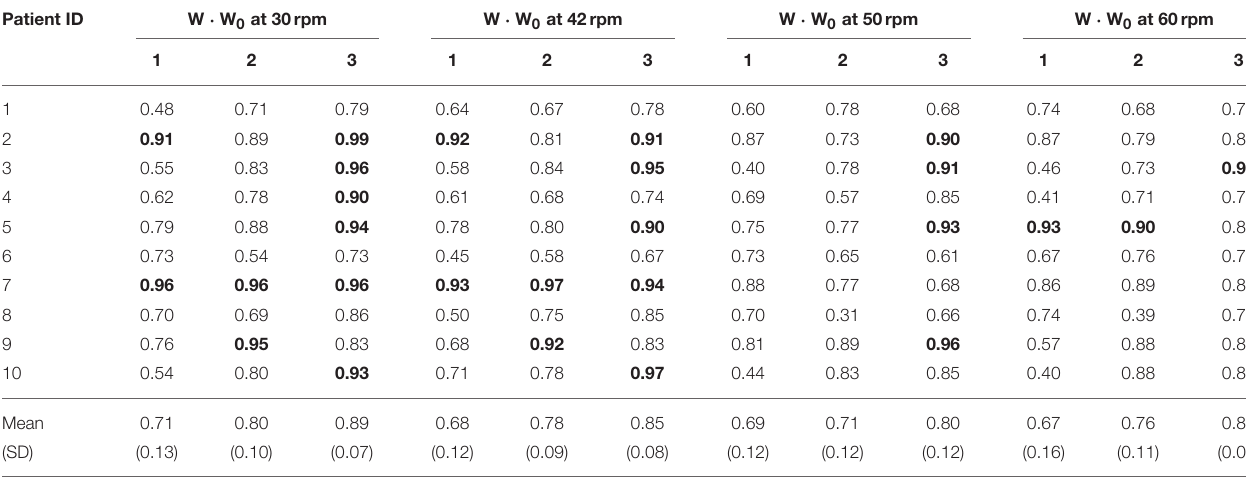
TABLE 3 | Normalized scalar product between matching muscle synergy vectors from matrices W of each patient and the matrix W 0 obtained from all healthy subjects pooled together, considering the set of 13 muscles. Patient ID